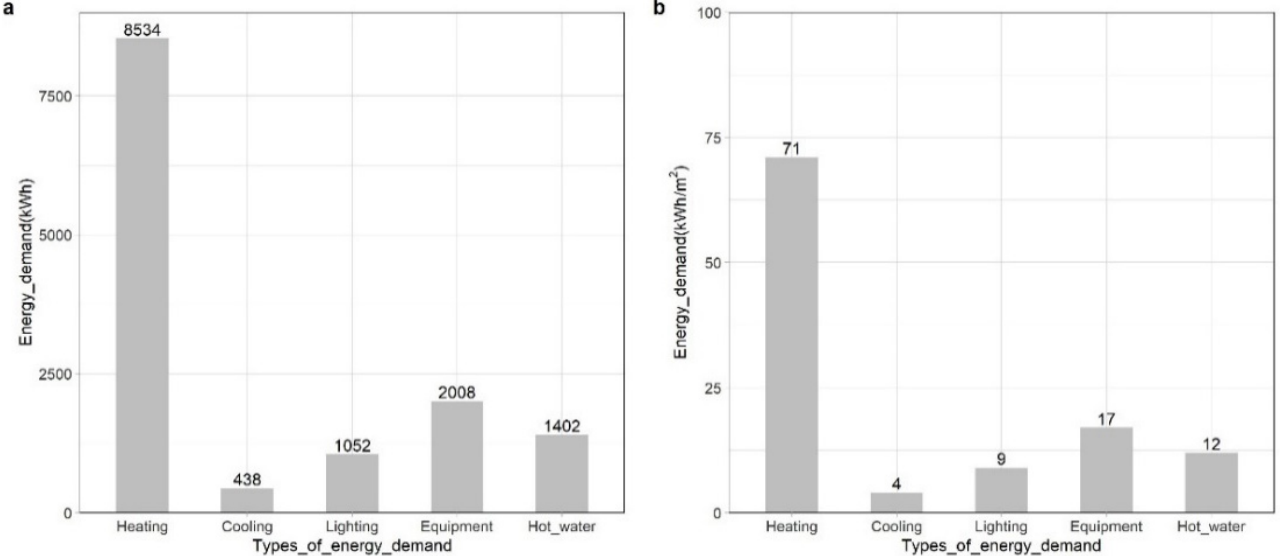
Figure 9. The annual energy demand of typical rural houses: ( a ) Annual total energy demand; ( b ) Annual per-square meter energy demand.